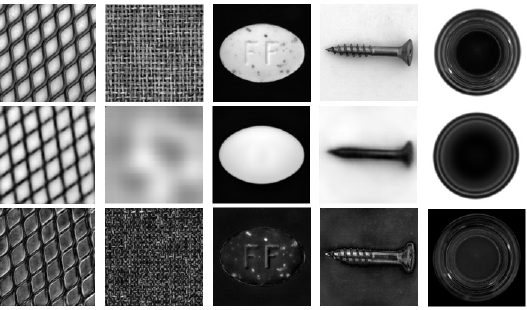
Figure 4. ( Top ) Original image. ( Middle row ) Reconstructed images from AE. ( Last row ) Difference images. The magnitudes of misalignment pixels are obviously high and result in false